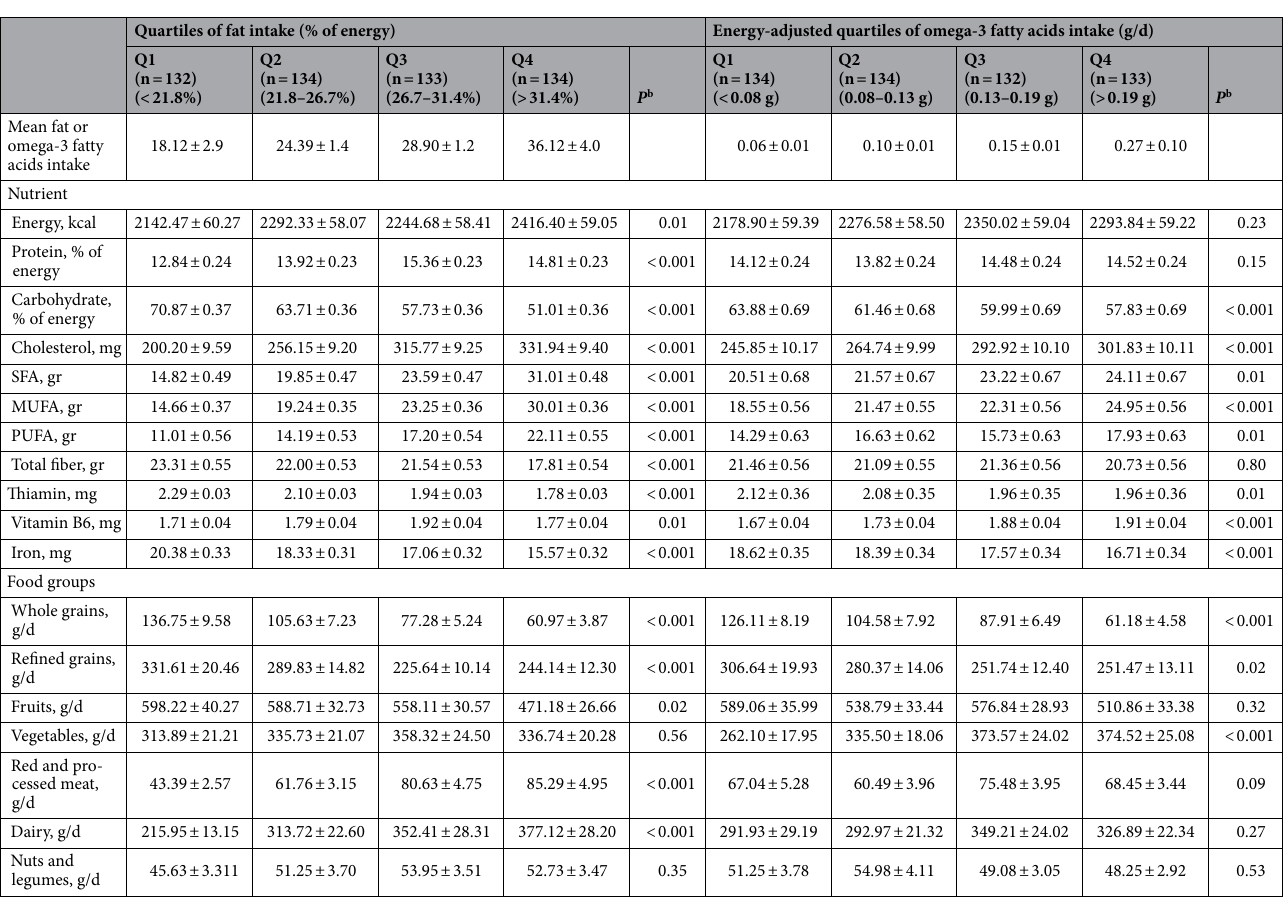
Table 2. Dietary intakes of study participants across quartiles of fat (as percentage of energy intake) and energy-adjusted omega-3 fatty acids intake a . a Values are mean ± SE. Intakes of energy and macronutrients were adjusted for age and sex, all other values are adjusted for age, sex and energy intake. b P -values obtained from ANCOVA. SFA, Saturated fatty acids; MUFA, Monounsaturated fatty acids; PUFA, Polyunsaturated fatty